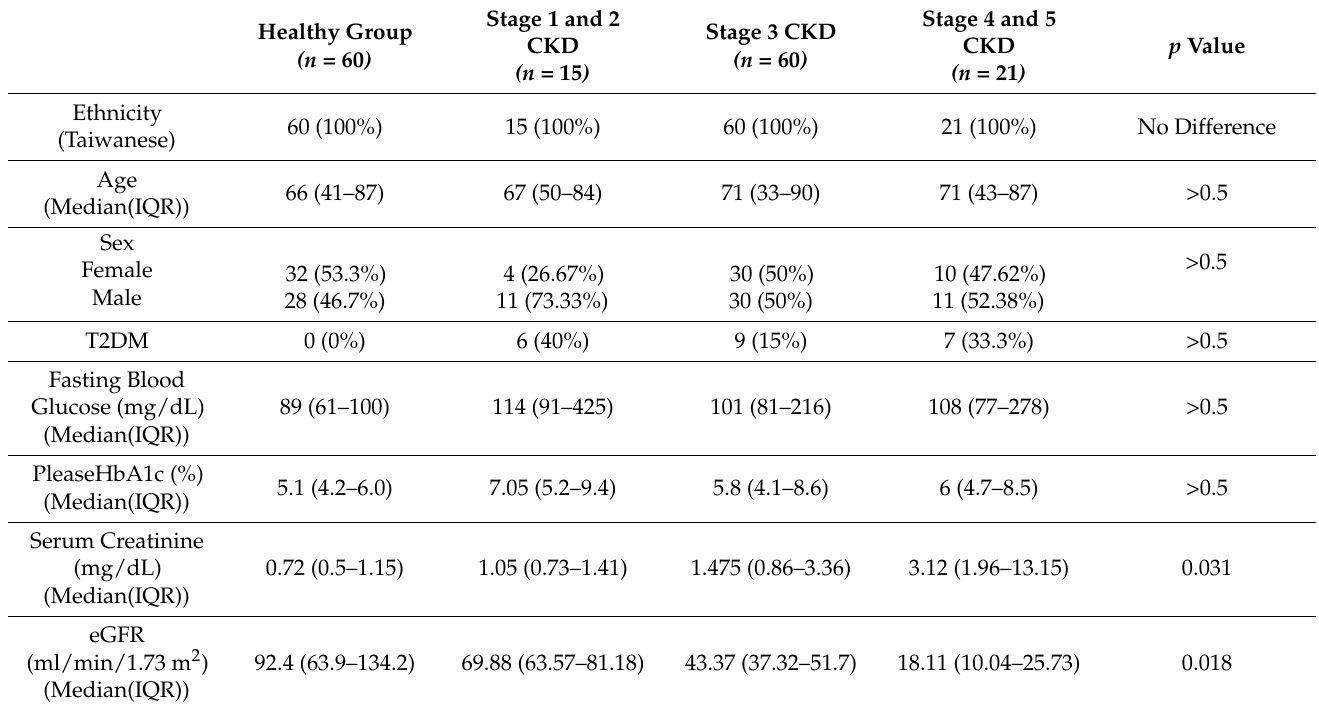
Figure 1. Flow chart demonstrates the enrollment of study participants. Table 1. Demographics of healthy participants and enrolled chronic kidney disease patients.